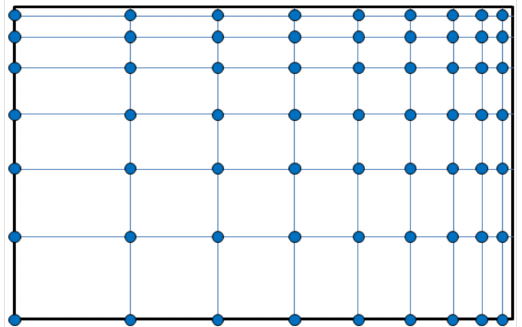
Figure 9. An example of a simple gradient metasurface; the structure is graded along both in- plane axes; blue circles represent meta-atoms, while blue lines denote the cells of the gradient subwavelength